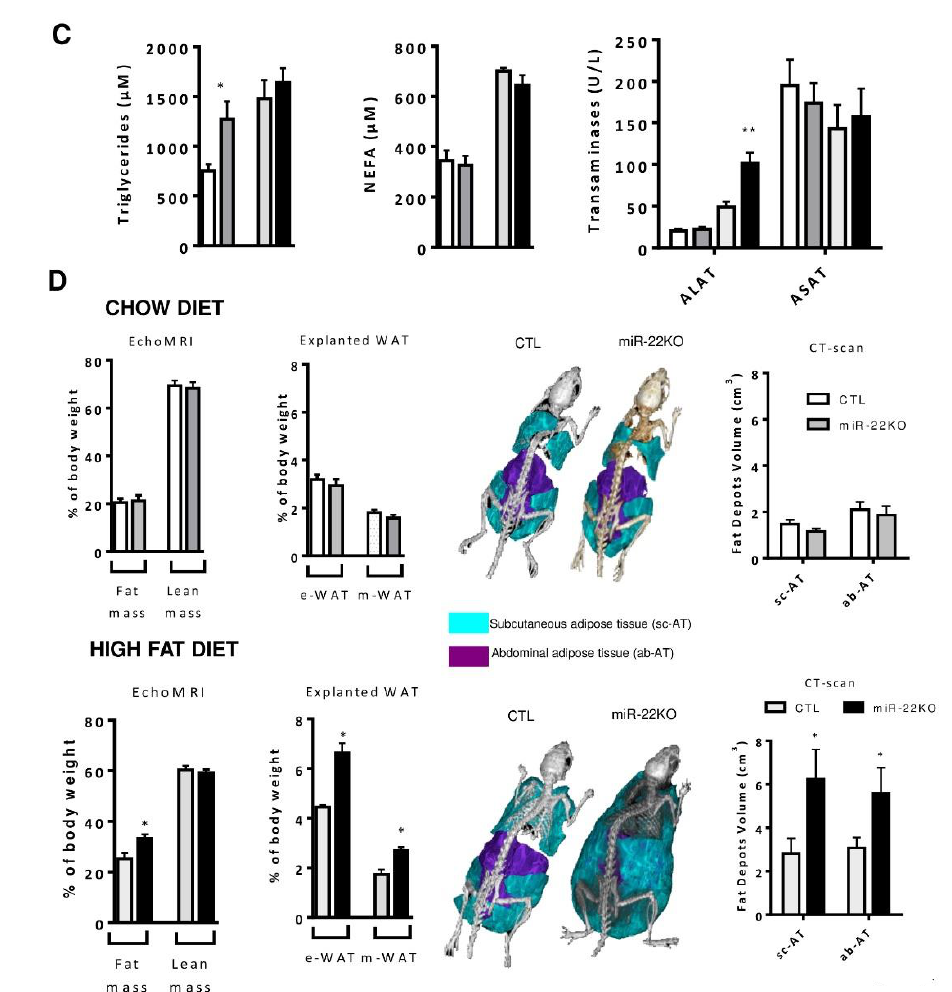
Figure 2. Mir22 deficiency promotes body weight gain and adiposity in mice fed an obesogenic diet. Two-months-old control (CTL) and miR-22KO mice were fed chow (CD) or high-fat containing diet (HFD) for 12 weeks. Panel ( A ) represents weight gain of CTL and miR-22KO mice fed CD or HFD. ( B ) Plasma cholesterol, low density lipoprotein (LDL) and high density lipoprotein (HDL) levels in CTL and miR-22KO mice fed CD or HFD. ( C ) Non-esterified fatty acids (NEFA), triglycerides and plasma transaminase (ALAT and ASAT) levels in CTL and miR-22KO mice fed CD or HFD. ( D ) EchoMRI analyses of fat and lean body mass (left panels), weights of explanted epidydimal (eWAT) and mesenteric (mWAT) white adipose depots (middle panels), and three-dimensional reconstitution and volume of CT-scan analyses of fat depots (sub-cutaneous, sc-AT; abdominal, ab-AT) in CTL and miR-22KO mice fed a CD or HFD for 12 weeks. (n = 5–12 mice per group and data are represented as means ± SEM). * p < 0.05, ** p < 0.01, *** p < 0.001, Panels A–C were analyzed with student t-test, panel D was analyzed with ANOVA).